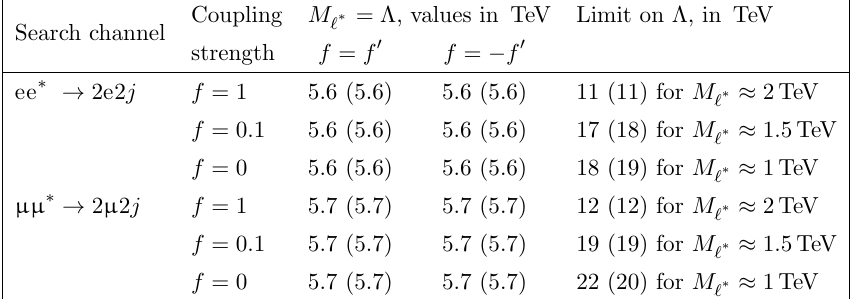
= (cid:3), for the cases ‘ (cid:3)